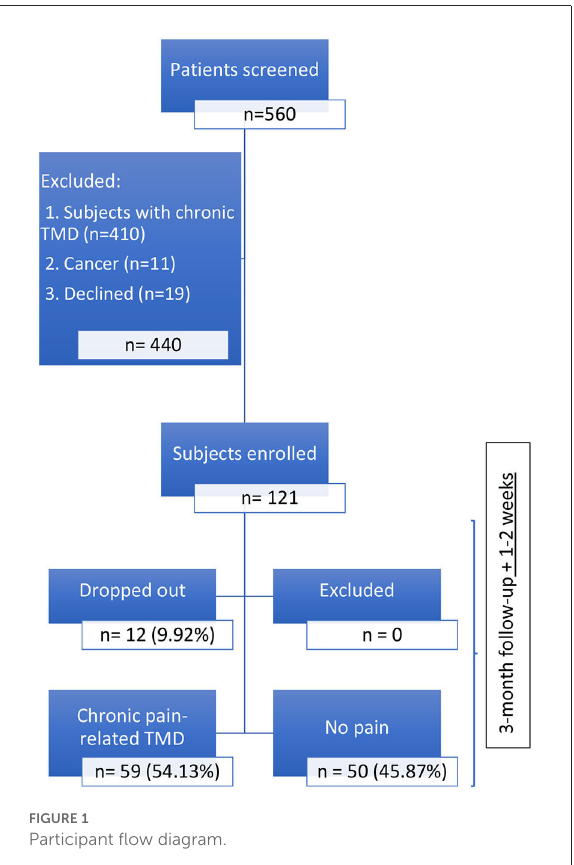
FIGURE1 Participant flow